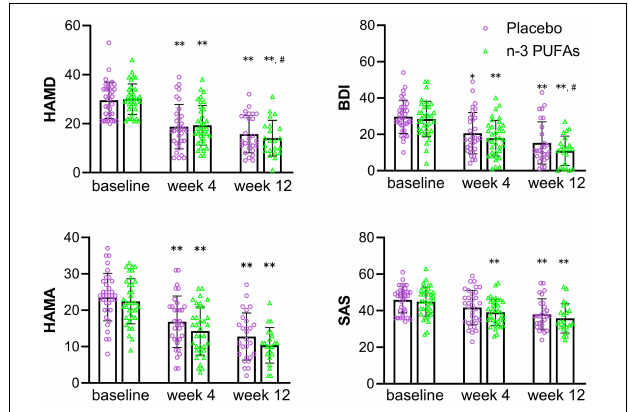
FIGURE 2 | The scores on depression and anxiety questionnaires in n-3 PUFAs and placebo group. ∗ significantly different compared with baseline, # significantly different compared with week 4, ∗ p < 0.05, ∗∗ p < 0.01, # p < 0.05, ## p < 0.01. n-3 PUFAs, Omega-3 polyunsaturated fatty acids; HAMD, Hamilton Depression Scale; BDI, Beck Depression Inventory; HAMA, Hamilton anxiety scale; SAS, Self-rating Anxiety Scale. For n-3 PUFAs group, n = 36, after week 4, n = 36, and after week 12, n = 21. For the placebo group, n = 36, after week 4, n = 33, and after week 12, n = 27.